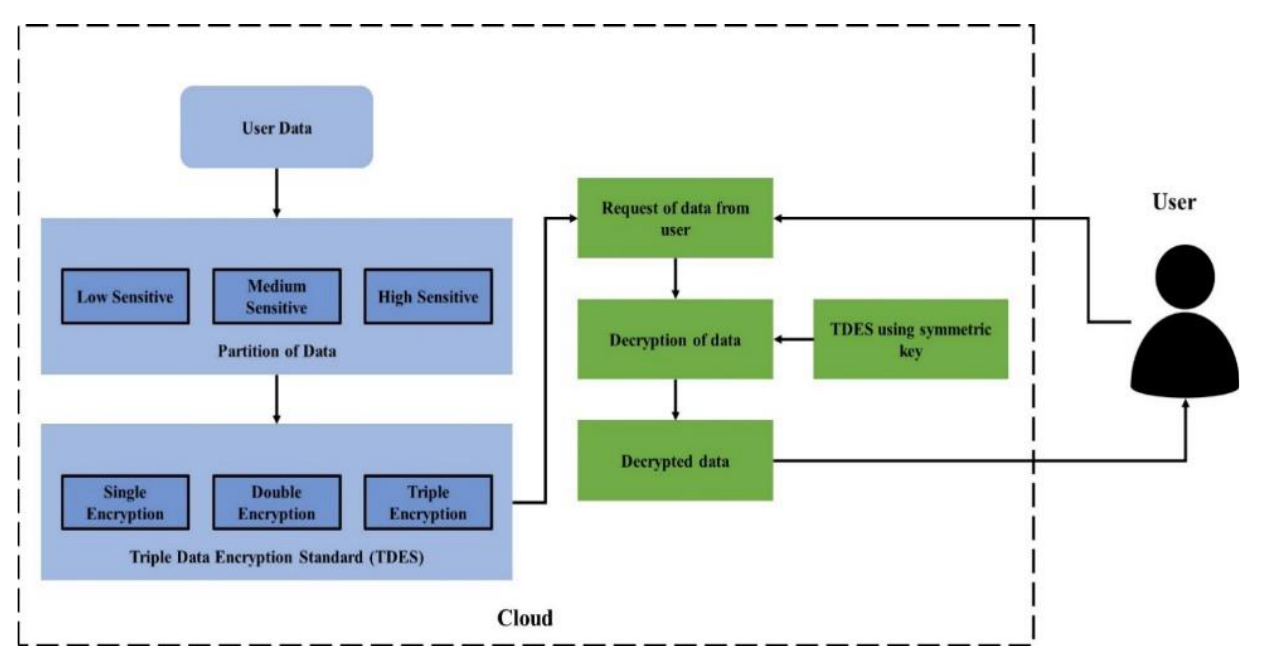
Figure 2. Block diagram of proposed TDES for secure big healthcare data storage in Cloud computing.